Question: What does this figure show? Answer in one sentence.
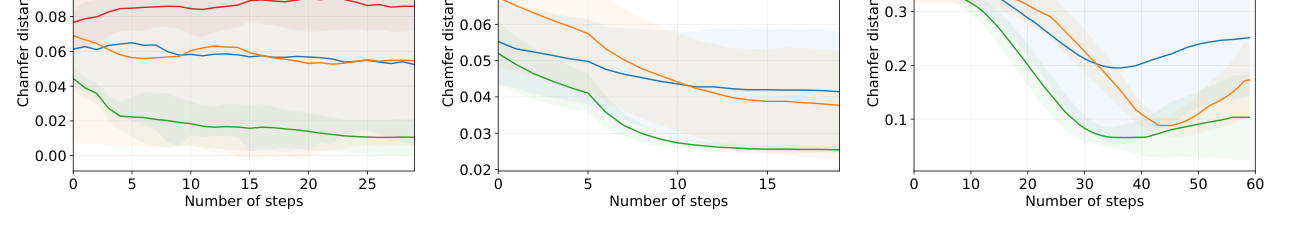
Answer: Real robot deformable object manipulation task results on three different materials. We report the averaged Chamfer distance (meters) over steps.